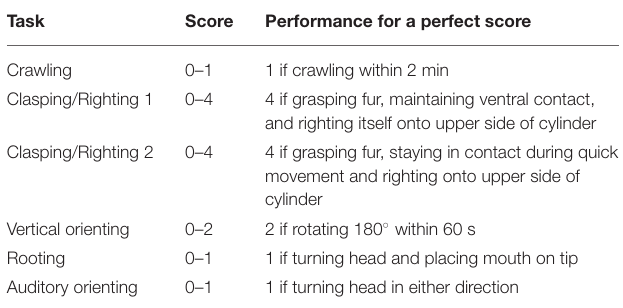
TABLE 1 | Matscore behavioral tasks description [Adapted from Tardif et al.